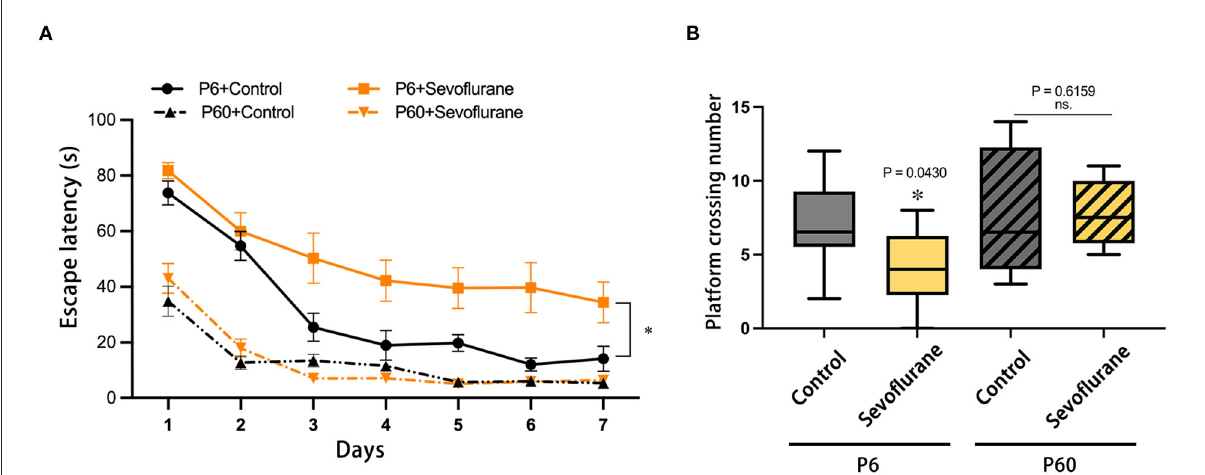
FIGURE2 Effects of multiple exposures to sevoflurane anesthesia to neonatal and adult mice on future spatial cognitive function in the test. (A) Swimming escape latency and (B) platform crossing number. n = 10 mice/group. Escape latency results are presented as mean ± standard error of the mean (SEM); the platform crossing number is expressed as median and interquartile range. * P < 0.05 vs. P6 + Control. MWM, Morris water maze; P6, postnatal day